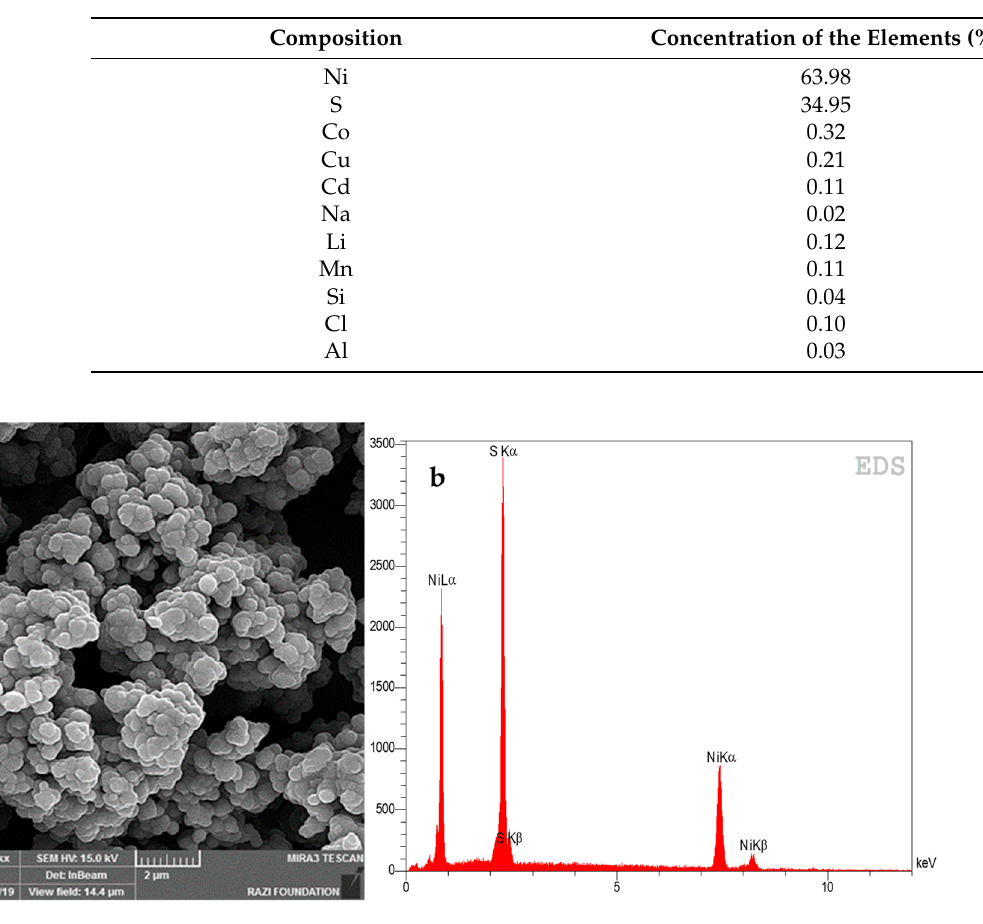
Figure 6. ( a ) SEM image and ( b ) EDS analysis from the as ‐ prepared NiS nanoarchitecture.